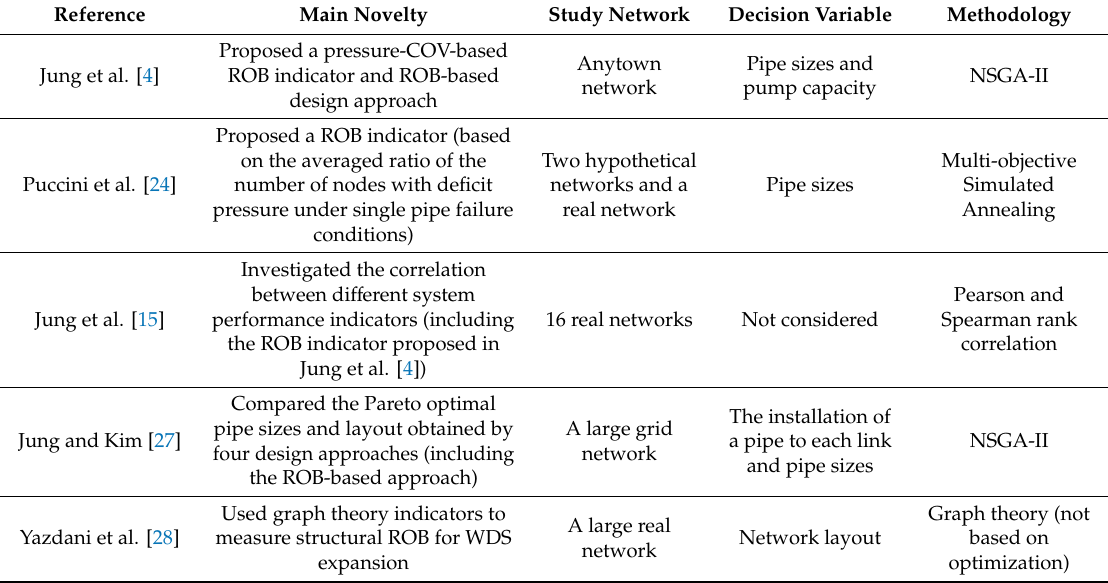
Table 1. Summary of a group of consequential ROB studies in the context of WDS